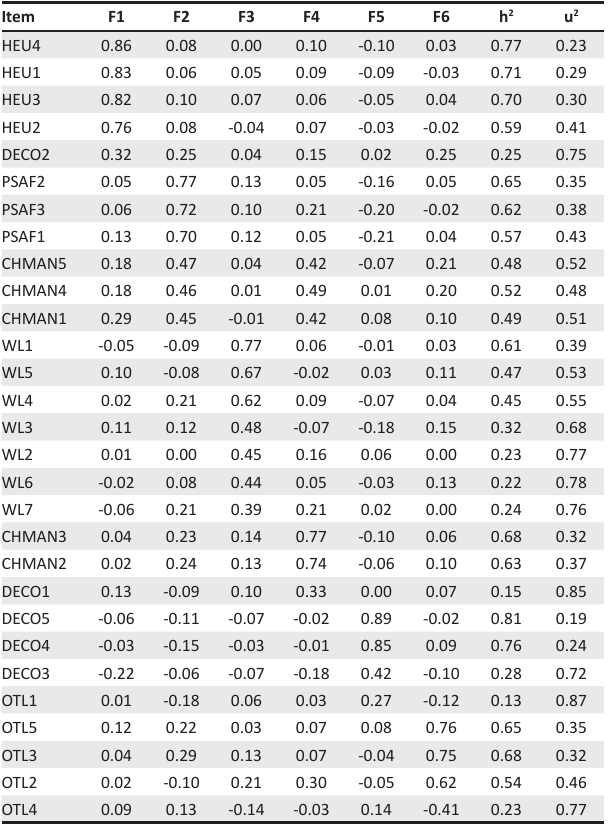
TABLE 1: Dimensionality analysis of the five-factor and six-factor